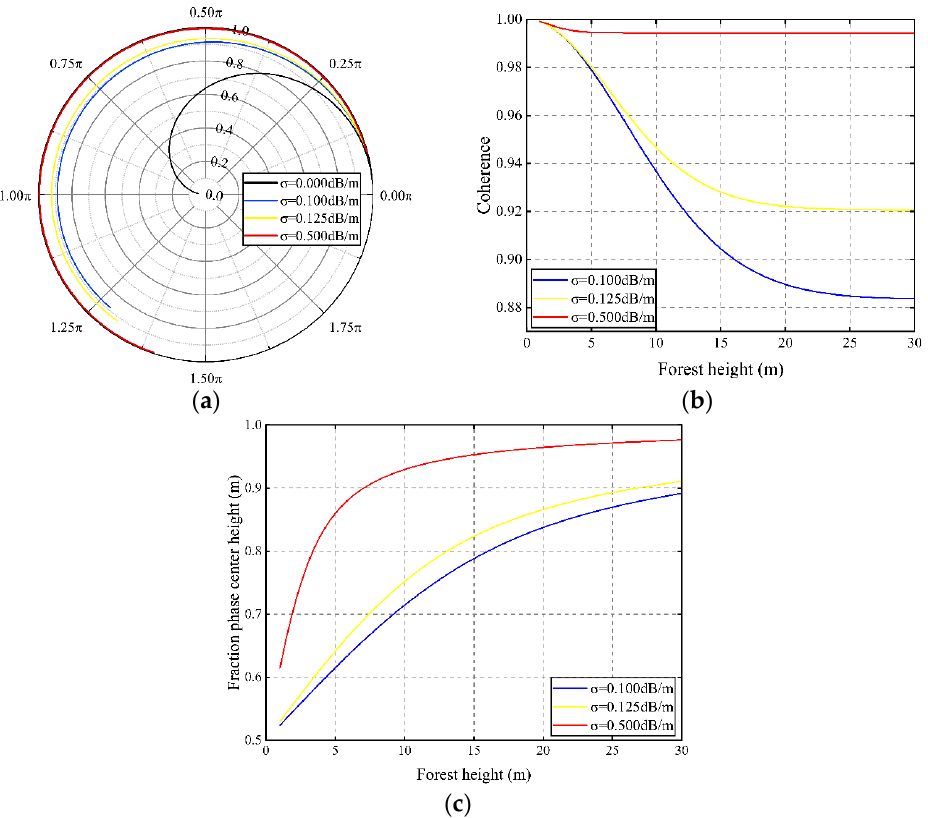
Figure 13. A presentation of the relationship between extinction coefficient, coherence amplitude, and phase. ( a ) The relationship between complex coherence and extinction coefficient in the complex unit circle. ( b ) The relationship between tree height, amplitude, and extinction coefficient. ( c ) The relationship between extinction coefficient and phase center height, tree height ( σ = 0 dB / m is the black line, σ = 0.1 dB / m is the blue line, σ = 0.125 dB / m is the yellow line, and σ = 0.5 dB / m is the red line.).